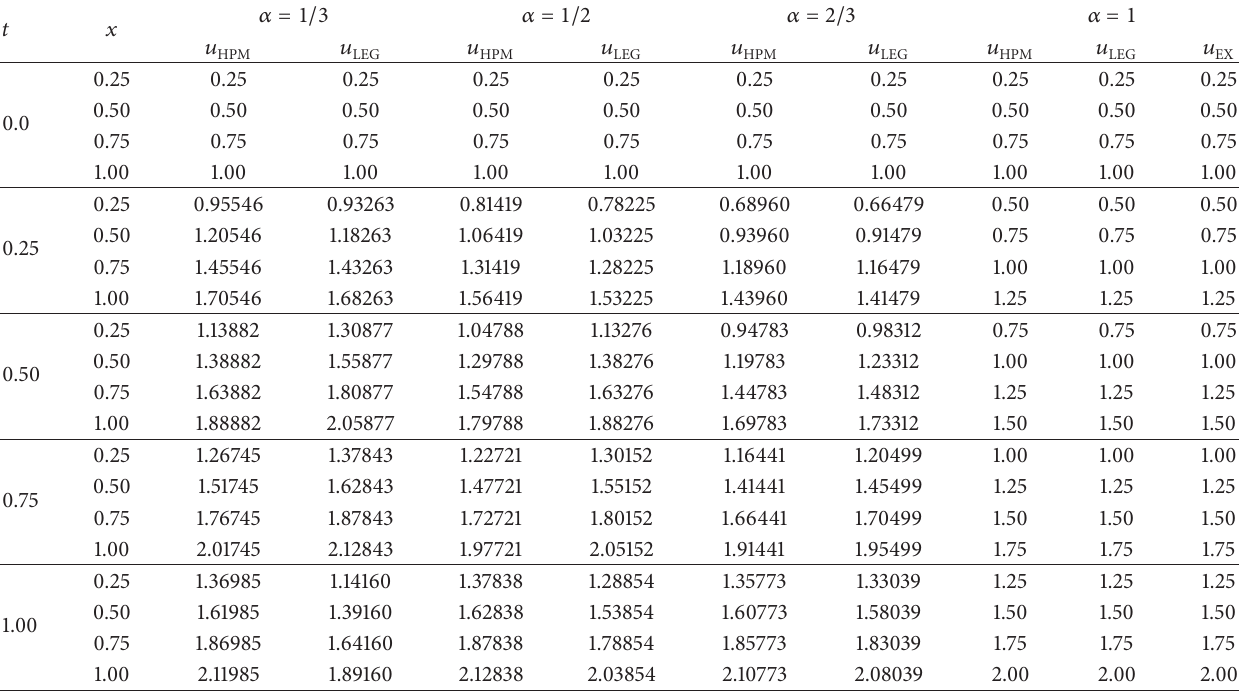
Table 1: Approximate solutions for Example 3.